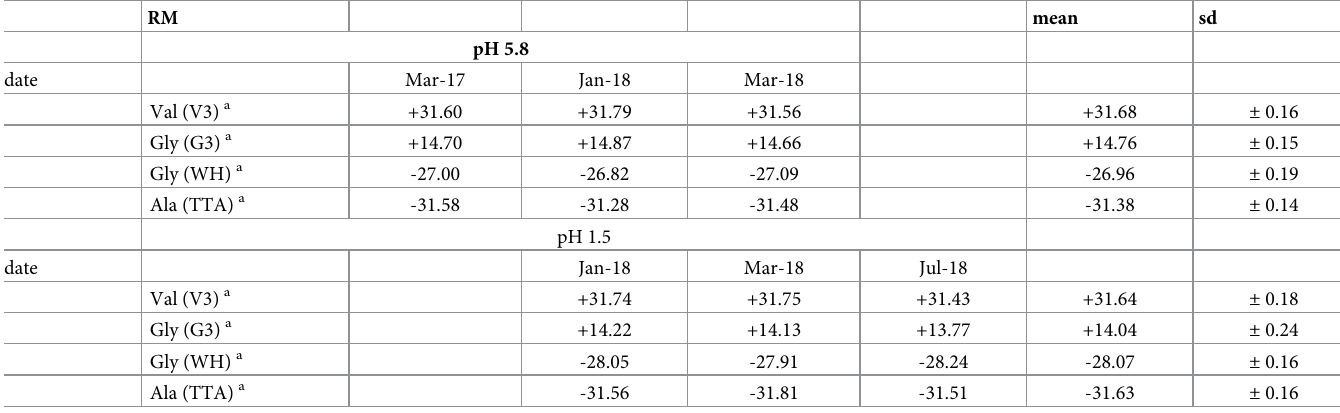
Table 3. Mean δ 13 C CARBOXYL values for RMs run with pH 5.8 and pH 1.5 reagents. RM